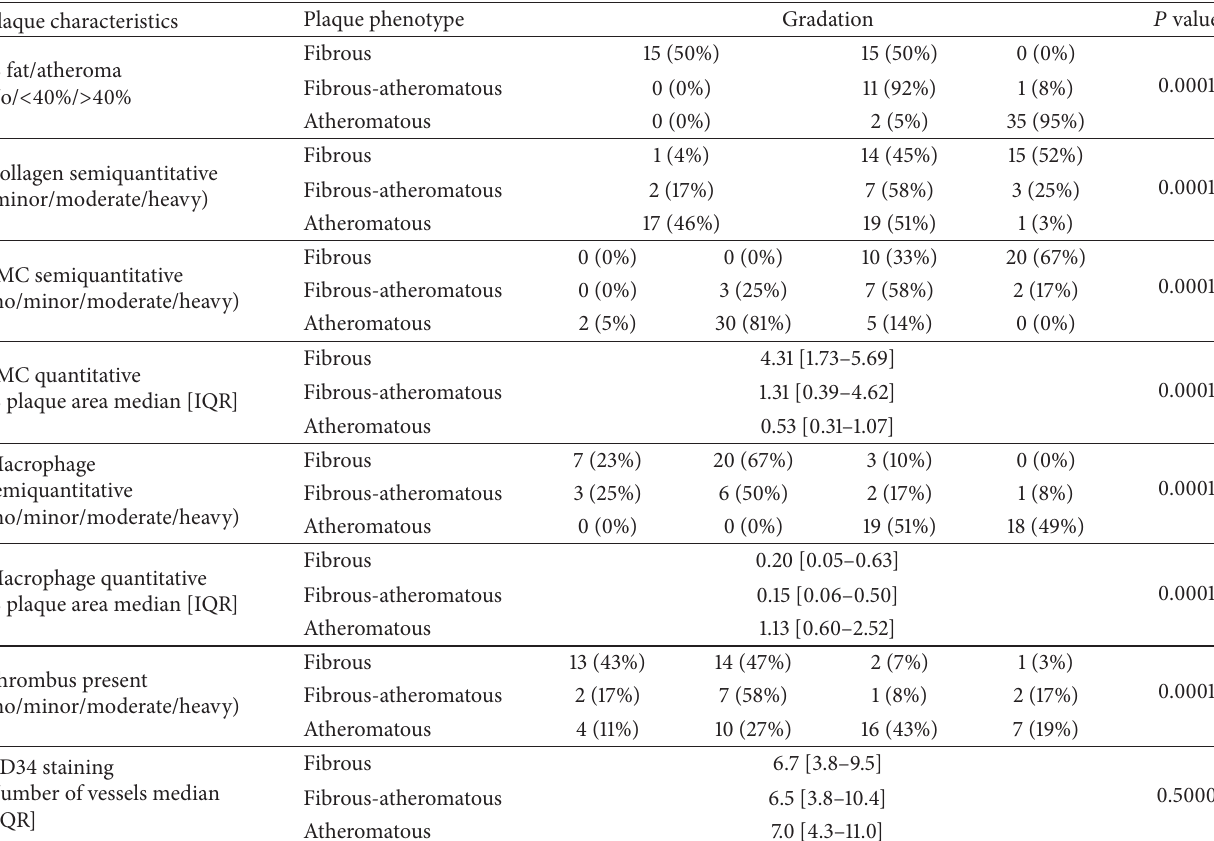
Table 3: Atherosclerotic plaque